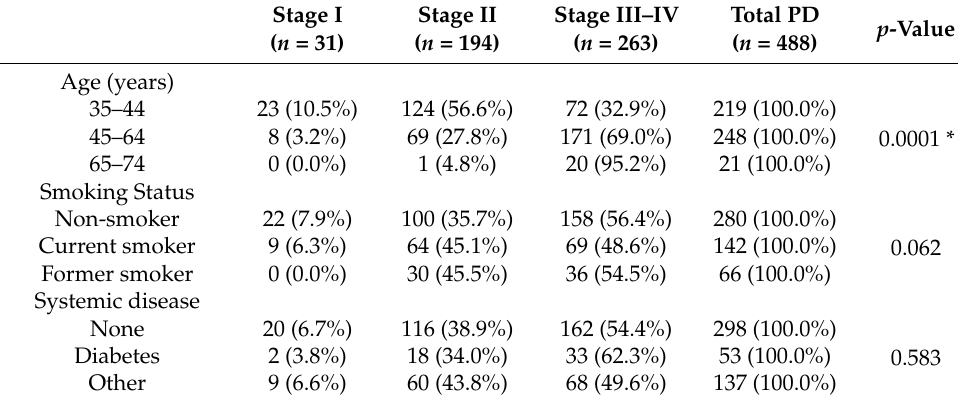
Table 3. The complexity of periodontitis management staging by the various characteristics of the EFP/AAP 2018